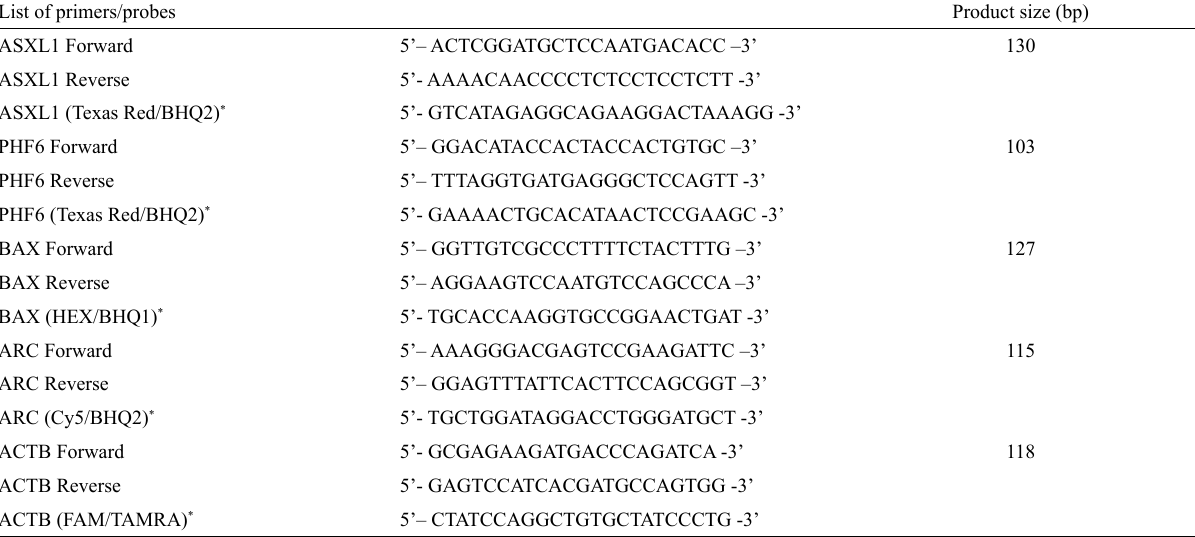
Table 1 - List of primers and probes, showing expected product size of each